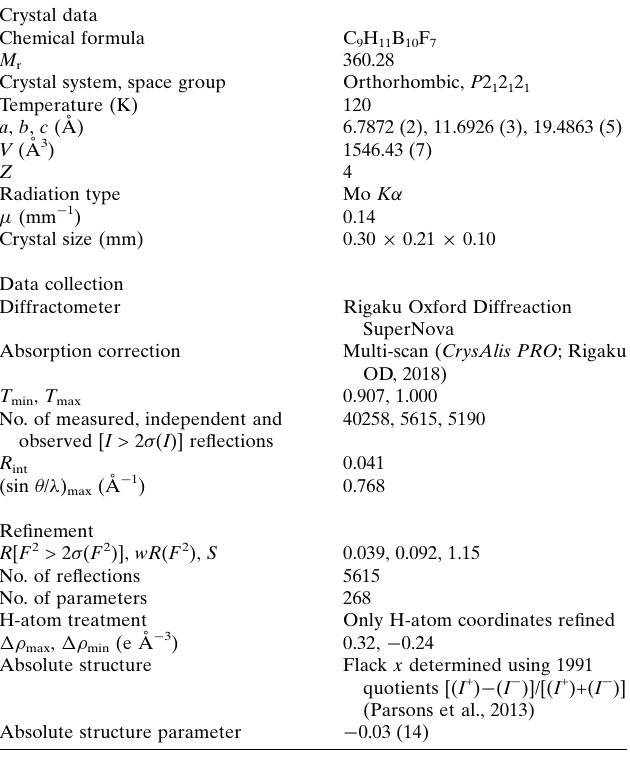
Table 2 Experimental details. Crystal data Chemical